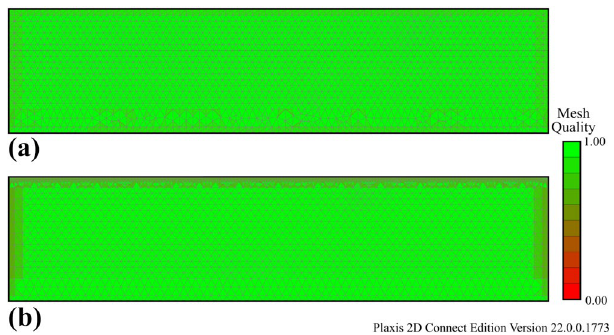
Figure 12. Quality of finite element mesh ( a ) Model 1, ( b ) Model 2 and Model